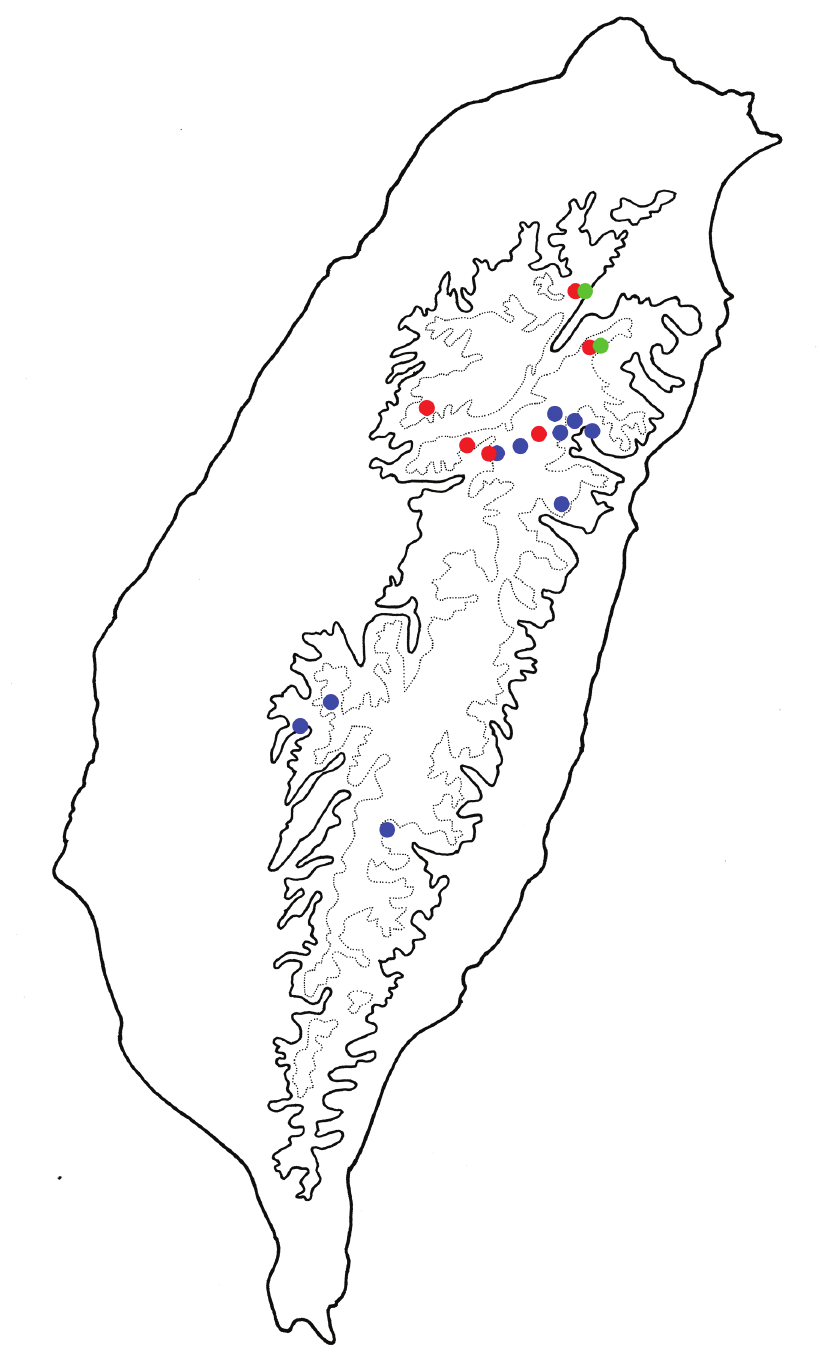
Figure 5. Distribution map of Taiwanoshaira species, solid line: 1000 m, broken line: 2000 m. Blue Dots T. chujoi comb. nov. Red Dots T. tsoui sp. nov. Green Dots T. taipingshanensis sp.